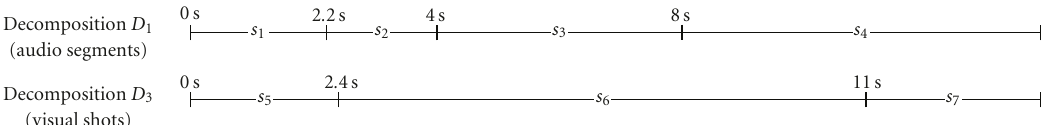
Figure 7: An example illustrating the use of function τ . For the depicted decompositions, τ ( s 3 , s 6 ) = (8 − 4) / (8 − 4) = 1; that is, in performing multimodal annotation of s 3 , the visual analysis results of s 6 would be taken into account with a temporal weight of 1 (since the only visual shot temporally overlapping with s 3 is s 6 ). On the contrary, τ ( s 6 , s 3 ) = (8 − 4) / (11 − 2 . 4) = 0 . 47 < 1, since s 3 is not the only audio segment temporally overlapping with s 6 . Thus, in performing multimodal annotation of s 6 , the audio analysis results of s 3 would be taken into account with a temporal weight of 0 . 47 and using this weight they would be combined (or would compete) with audio analysis results coming from s 2 and s 4 that also temporally overlap with s 6 ; the sum of temporal weights for s 2 , s 3 , and s 4 would be equal to